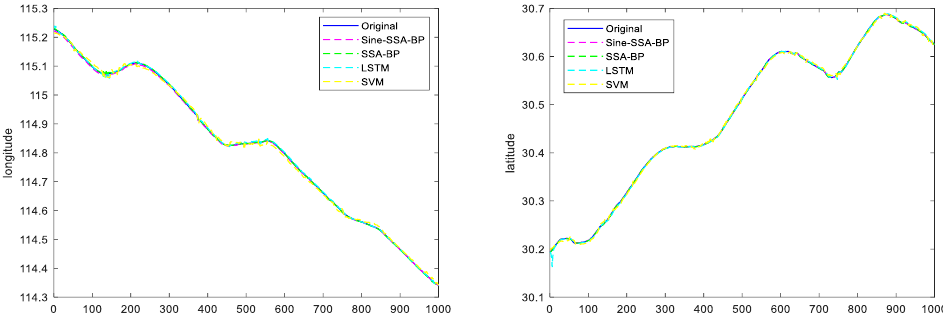
Figure 14 . Plots of predicted longitude and latitude for different model trajectories in Scenario 2.